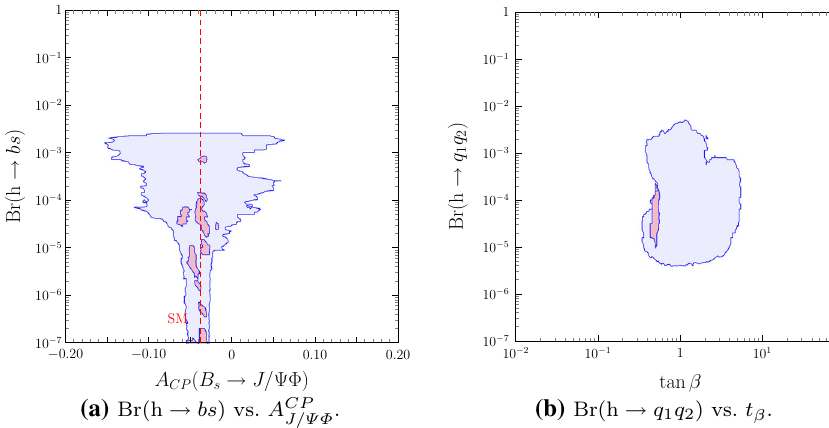
Fig. 10 Region allowed at 99% CL by the requirements of the full analysis (see Fig. 6)